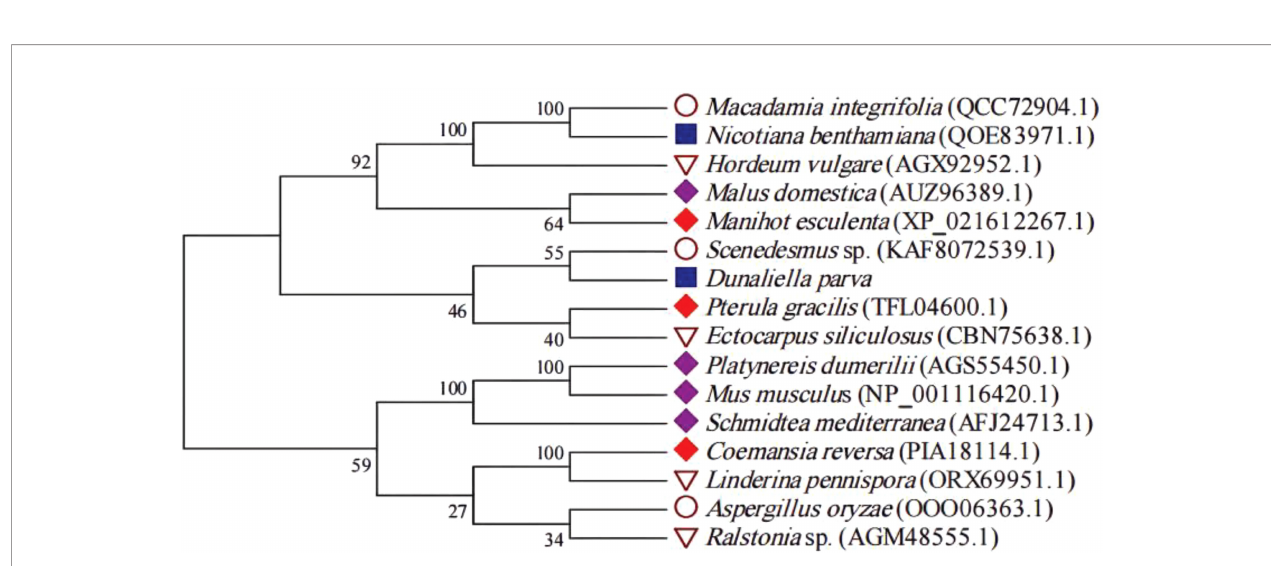
FIGURE 5 | Phylogenetic tree of AP2 proteins. The tree was constructed based on the complete protein sequences of AP2 proteins by the neighbor-joining method of the MEGA